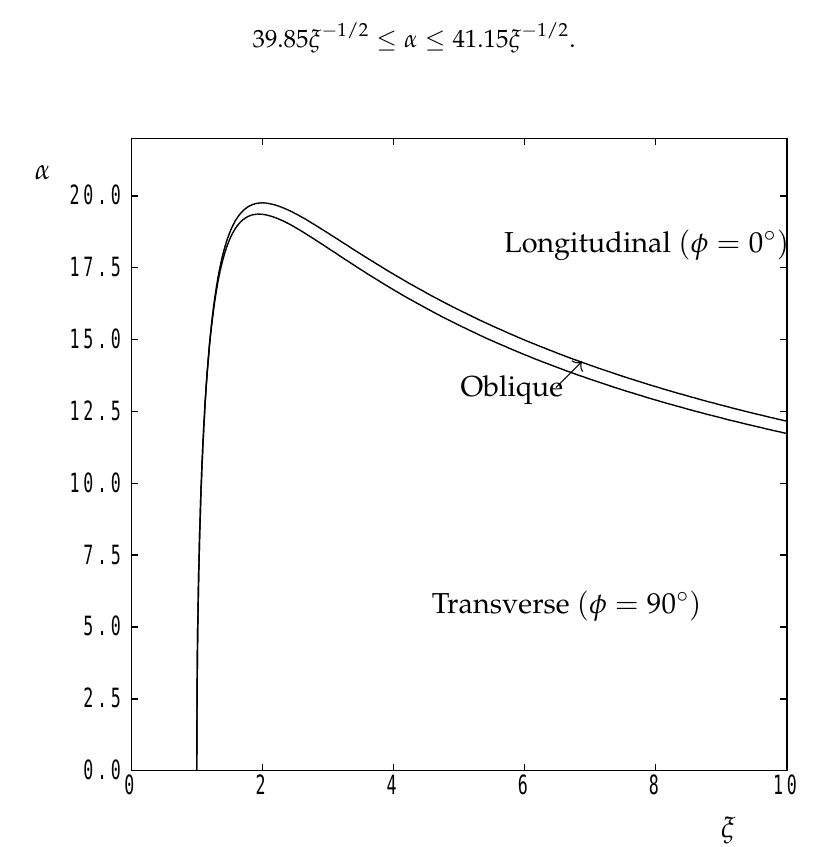
Figure 11. Showing the different regions in ( ξ , α ) –space wherein longitudinal rolls, oblique rolls (between the two curves) and transverse rolls form the most unstable planform of convection.